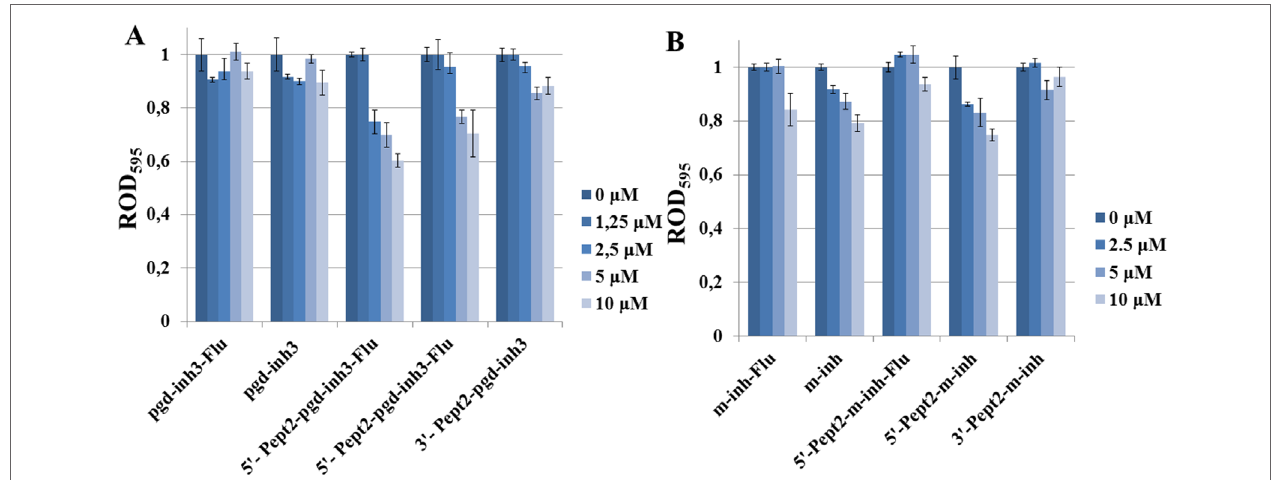
FIGURE 6 | Influence of the peptide conjugates of inhibiting phosphoryl guanidine oligonucleotide (A) and oligo(2’-O-methylribonucleotide) (B) on E. coli growth. Concentrations of conjugates in the media were 0–10 µM. Bacterial cells were incubated in the cell culture plate (96-well) at 37°C and 580 rpm during 22 h. ROD 595 —relative optical density, the ratio of OD 495 for the sample and oligonucleotide-free control. Values are mean ± SD (n =